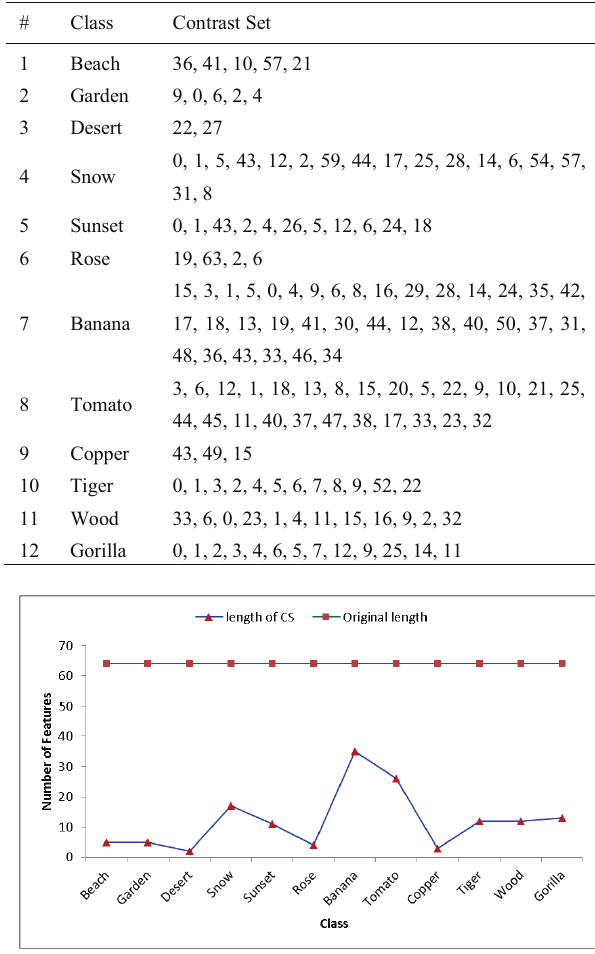
Fig. 1. The relative length of the discovered contrast sets from the Image dataset to the length of the original feature vector. The DisCoSet algorithm was applied on the CMU mocap dataset and the resulting lengths of discovered contrast set are as shown in Fig. 2. In the dataset, 13 joints on the human body are tracked for an entire action sequence. Trajectory of each joint, considered as a time series, is converted to SAX representation of length